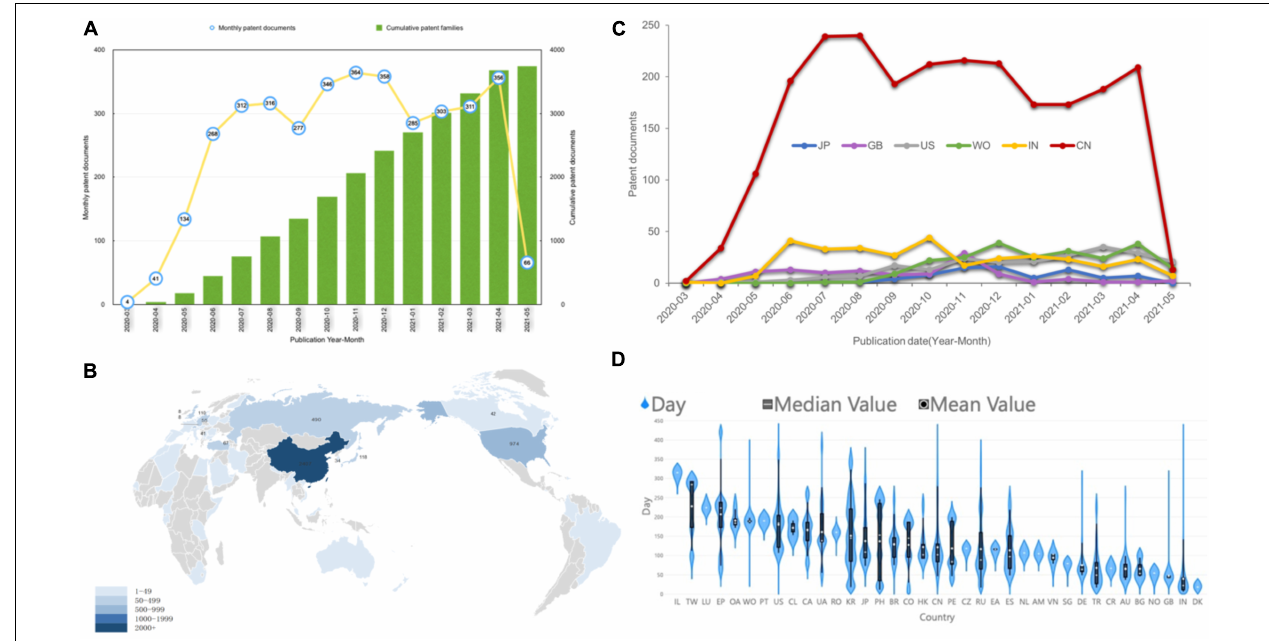
FIGURE 1 | Current tendency for time and geographical distribution of COVID-19 patents. (A) The annual and cumulative number of COVID-19 patents. (B) The country landscape by nationalities of jurisdictions. The darker the color, the more patents. (C) The map shows the number of patent families by the top six locations of patent inventors temporally. (D) Violin plot of the time period between patent application and publication. The short white horizontal line is the median; the white dot is the mean; the black bar in the center of the violin is the interquartile range; and the black lines stretching from the bar are defined as the first quartile –1.5 IQR and third quartile + 1.5